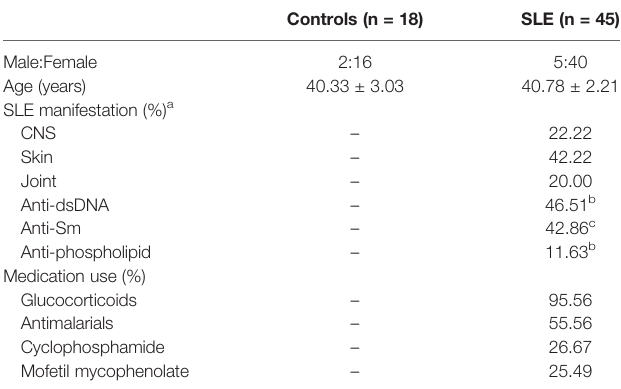
TABLE 1 | Demographics clinical characteristics and medication use of